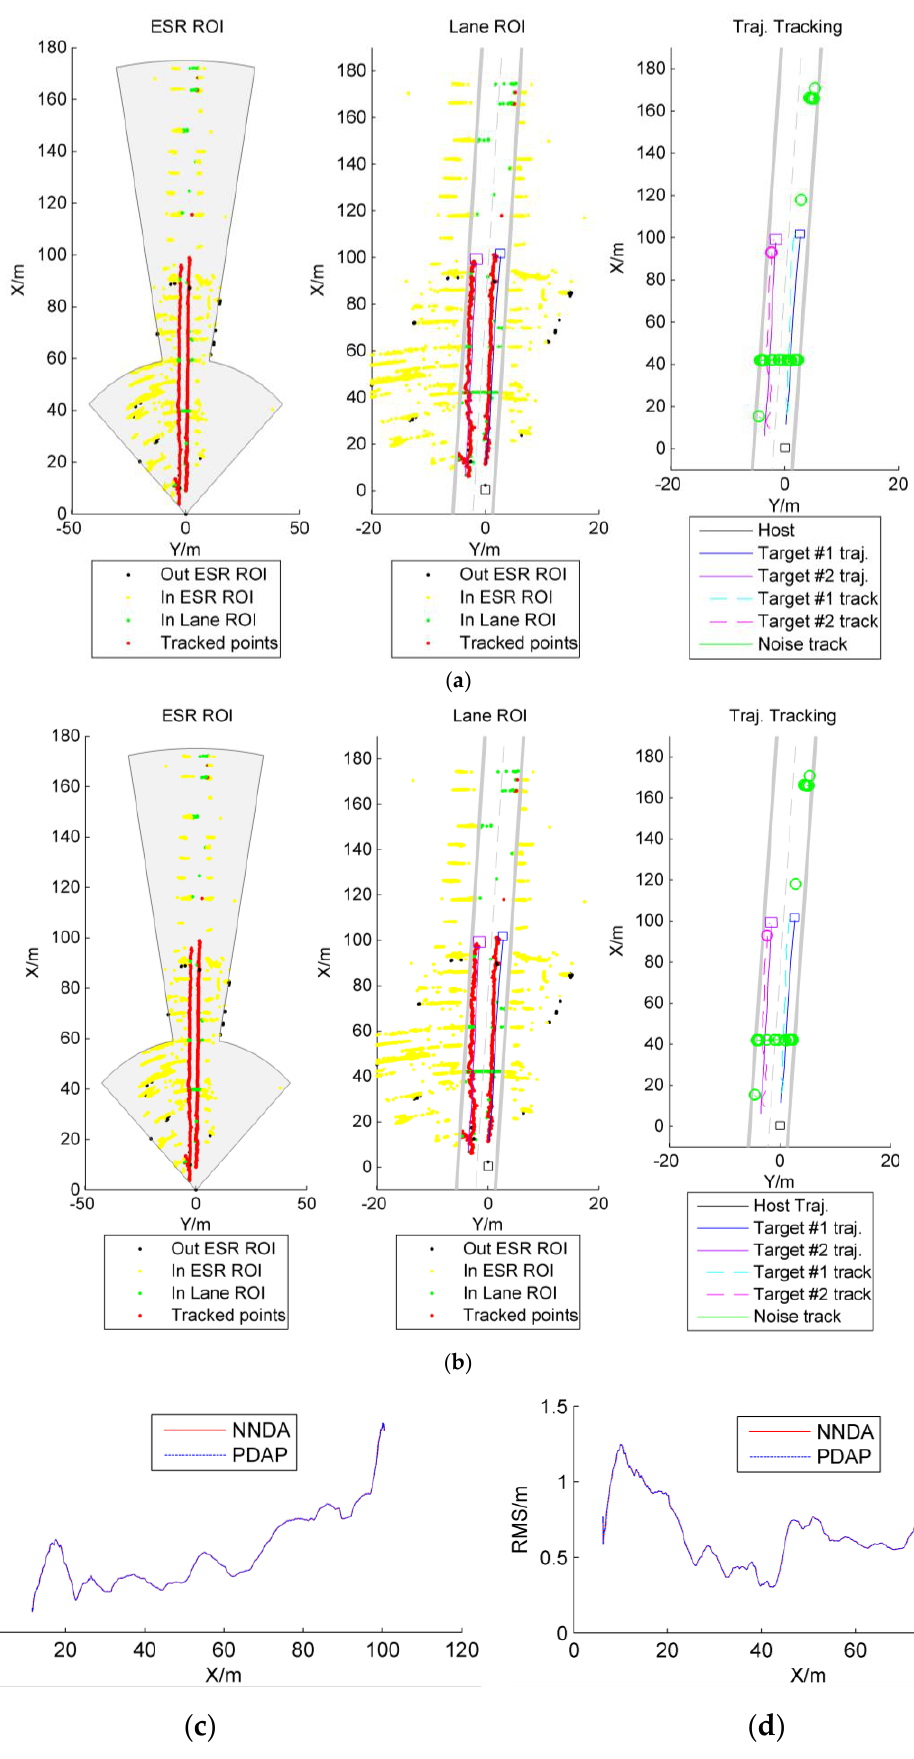
Figure 5. Real test for scenario 1. ( a ) NNDA-CT-UKF multitarget tracking; ( b ) PDAP-CT-UKF multitarget tracking; ( c ) RMS for tracking target #1; ( d ) RMS for tracking target #2.